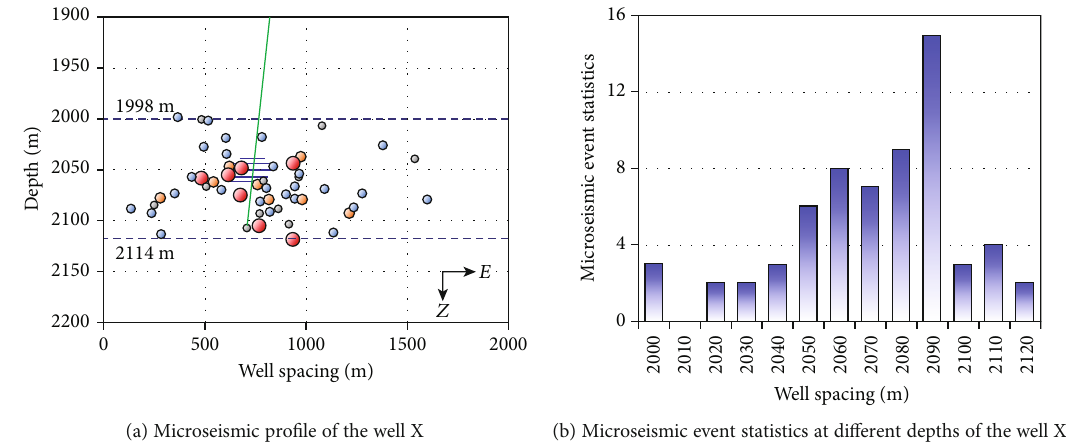
(b) Microseismic event statistics at di ff erent depths of the well X Figure 10: Modeling correctness veri fi cation using microseismic data.